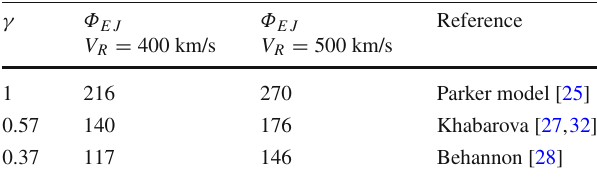
Table 1 The angle Φ EJ (degree) for V R = 400 km/s and V R = 500